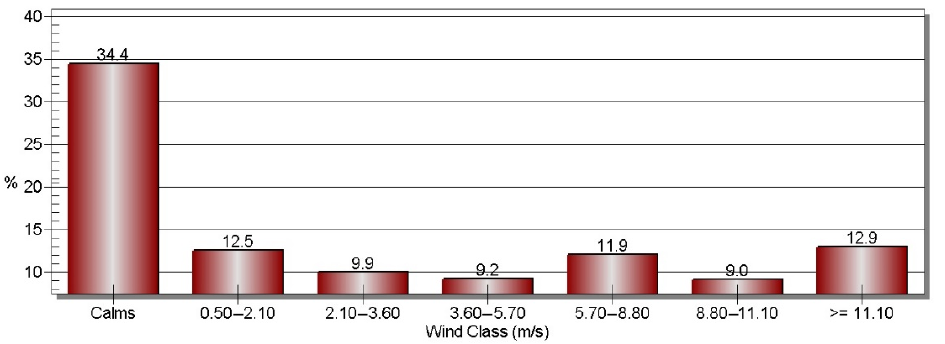
Figure 2. Wind class frequency distribution.